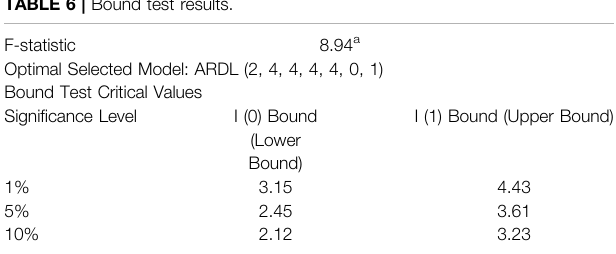
TABLE 6 | Bound test results. TABLE 7 |